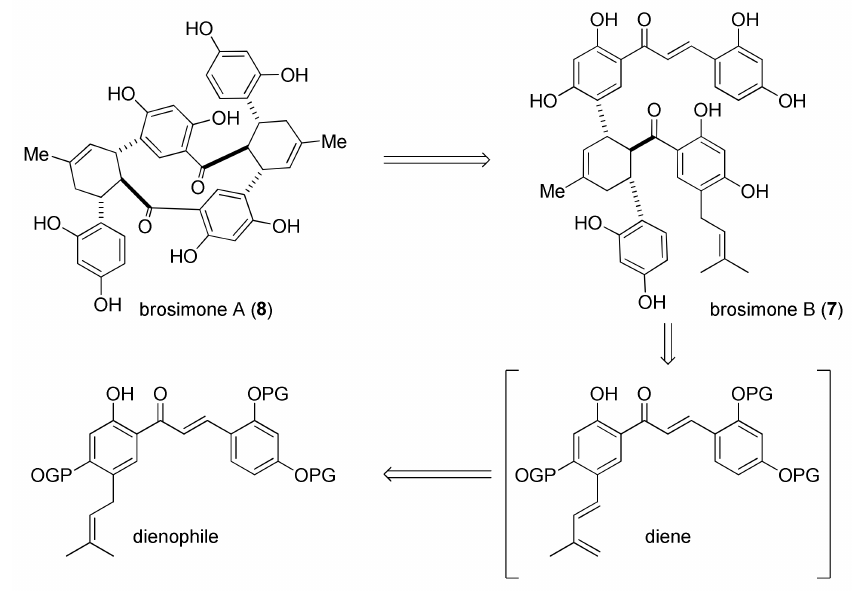
Figure 37. Retrosynthesis of brosimone A, derived from brosimone B.